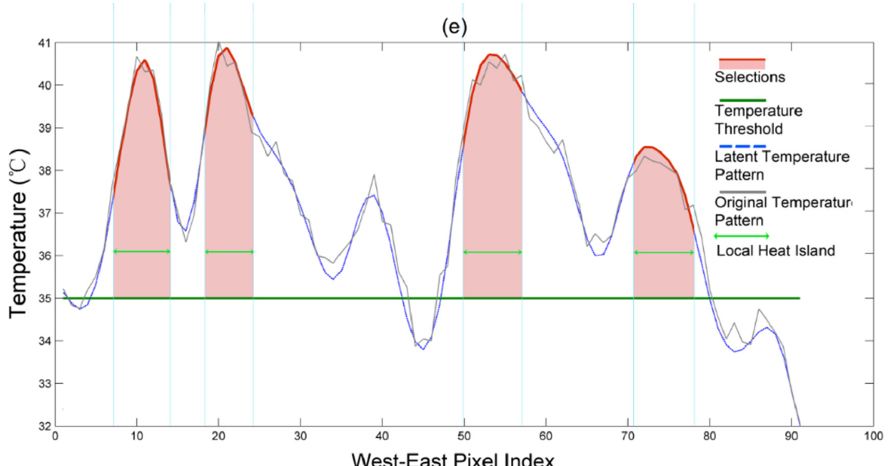
Figure 9. Selection of LST pixels satisfies MSSI > 0.50, curvedness > 0.05, and temperature > 34.87 °C. ( a ) The sample column from the latent LST at 13:30 July; ( b ) The temperature profile of the latent LST sample superimposes over the original noisy data while the temperature threshold is also shown; ( c ) The MSSI and curvedness of the sample used as criteria; ( d ) The scale is also shown along the MSSI; ( e ) The resulting selection.